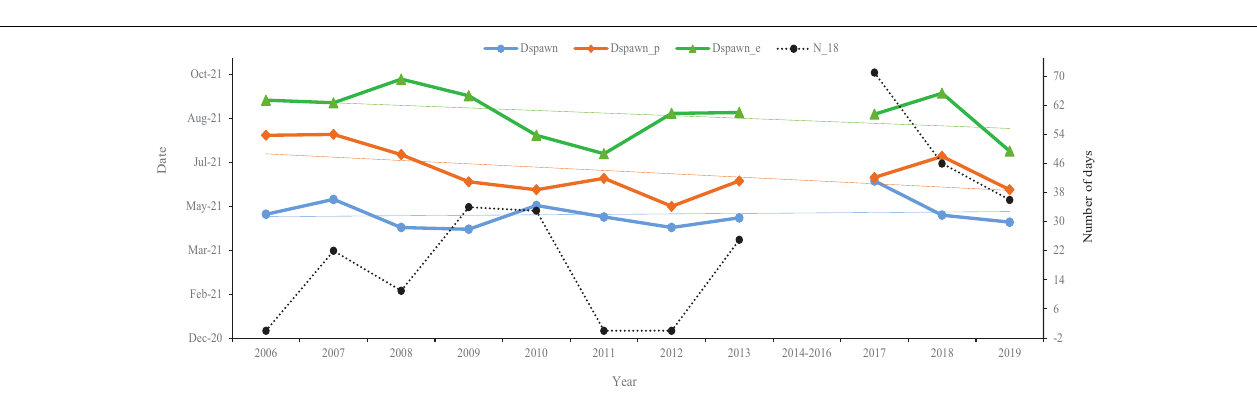
FIGURE 2 | Discharge (A) and temperature (B) suitability curves for the spawning of silver carps. The data are collected in the Pearl River (China) during 2006–2013 and 2017–2019. The occurrence of spawning represents the number of spawning days at a given discharge or temperature. The discharge suitability index (DSI) and temperature suitability index (TSI) range from 0–1.